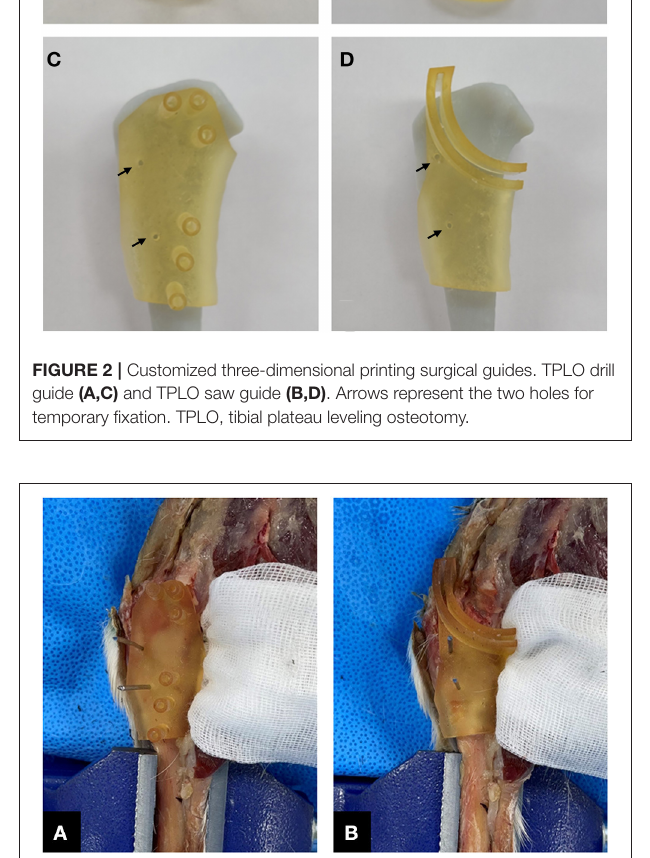
FIGURE 3 | Application of the customized three-dimensional printing surgical guides intraoperatively. TPLO drill guide (A) and saw guide (B) are temporarily fixed by two Kirschner wires. TPLO, tibial plateau leveling